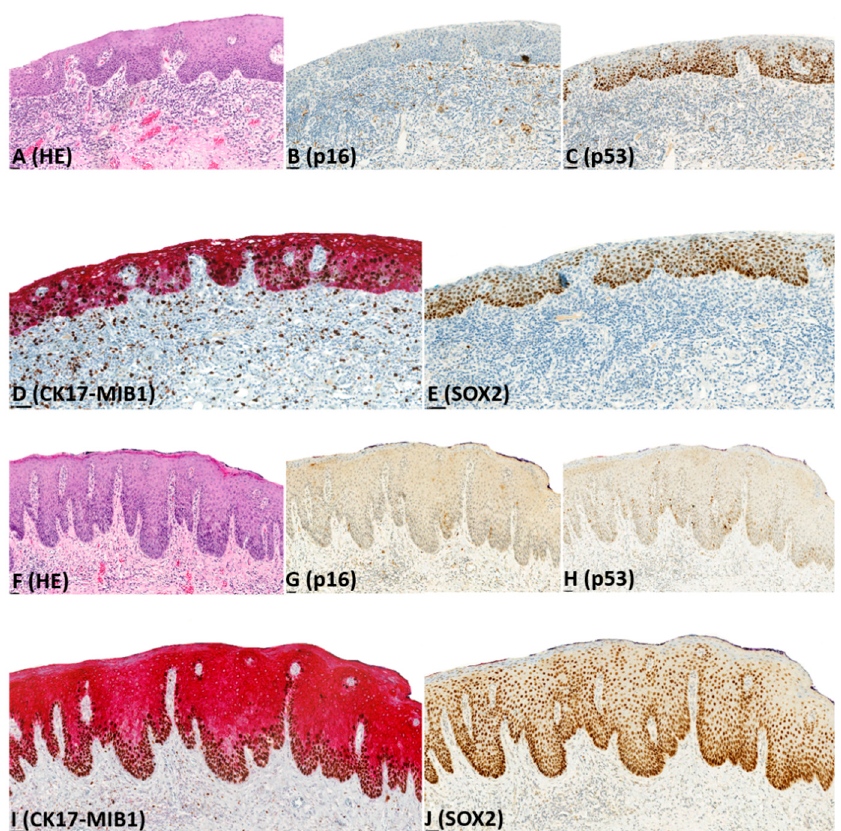
Figure 2. Example of immunohistochemical expression of p16, p53, CK17, MIB1, and SOX2 in differ- entiated vulvar intraepithelial neoplasia (dVIN); ( A ) Histological appearance of dVIN (HE-stain); ( B ) complete lack of p16-expression; ( C ) mutant pattern (basal and parabasal overexpression) of p53-expression; ( D ) diffuse, strong CK17-expression across full epithelial thickness and increased MIB1-expression; ( E ) diffuse, strong SOX2-expression across full epithelial thickness; ( F ) Histologi- cal appearance of dVIN (HE-stain); ( G ) complete lack of p16-expression; ( H ) wild-type (scattered) p53-expression; ( I ) diffuse, strong CK17-expression across full epithelial thickness and increased MIB1-expression; ( J ) diffuse, strong SOX2-expression across full epithelial